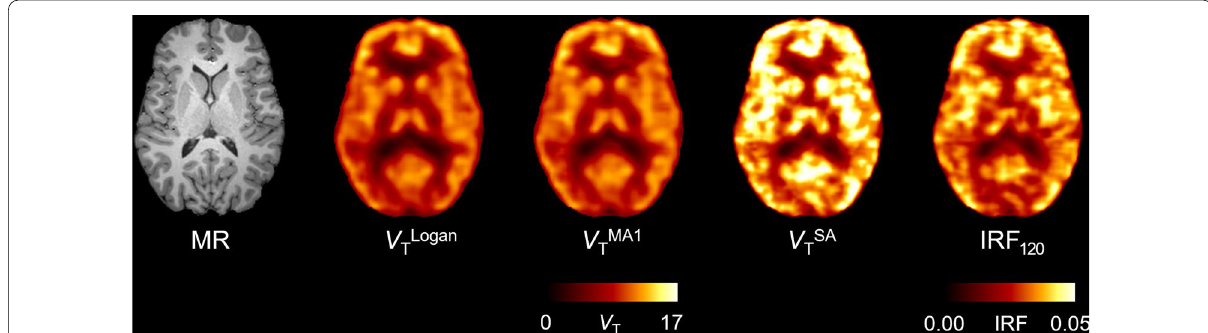
Fig. 1 The trans‑axial parametric images generated by different kinetic models in a single healthy volunteer. Total distribution volume ( V T, mL∙cm − 3 ) was obtained with Logan ( V TLogan ), multilinear analysis‑1 ( V TMA1 ), and standard spectral analysis ( V TSA ) . Impulse response function was calculated at 120 min (IRF 120 )